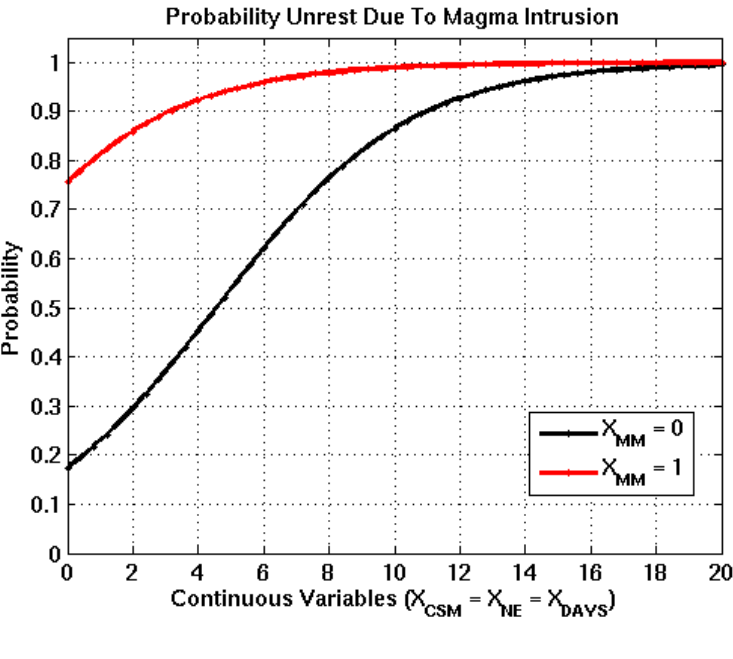
Figure 2. Logistic functions derived from bootstrapping process for the intrusion node, where the black and red curves represent X from 0 to 1 increases the probability of occurrence by 0.60, which is the difference between the black and red curves when all continuous input variables are equal to